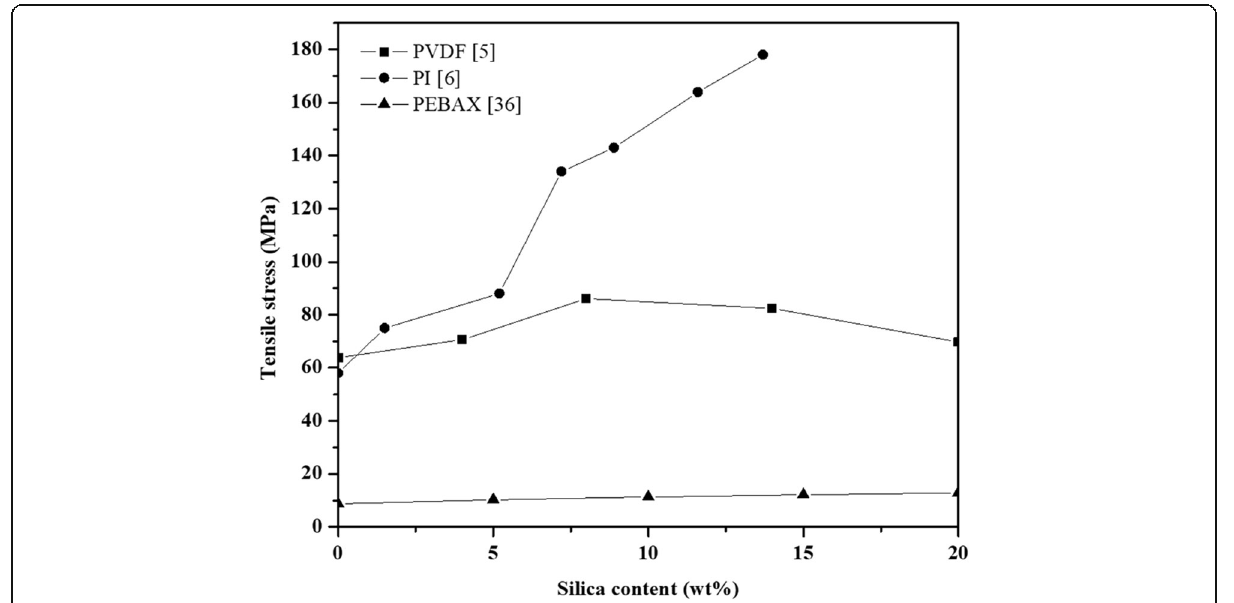
Fig. 11 Tensile stress of MMMs containing silica (PVDF: polyvinylidene fluoride; PI: polyimide; PEBAX: polyether block amide)